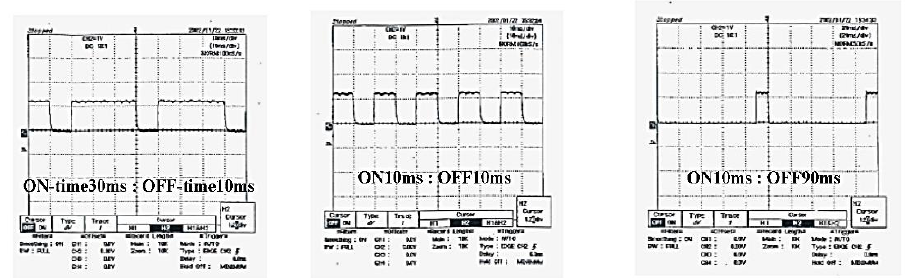
Figure 15. Typical waveform of invertor-type SPS pulse generator (ON-OFF ratio in 50 Hz).